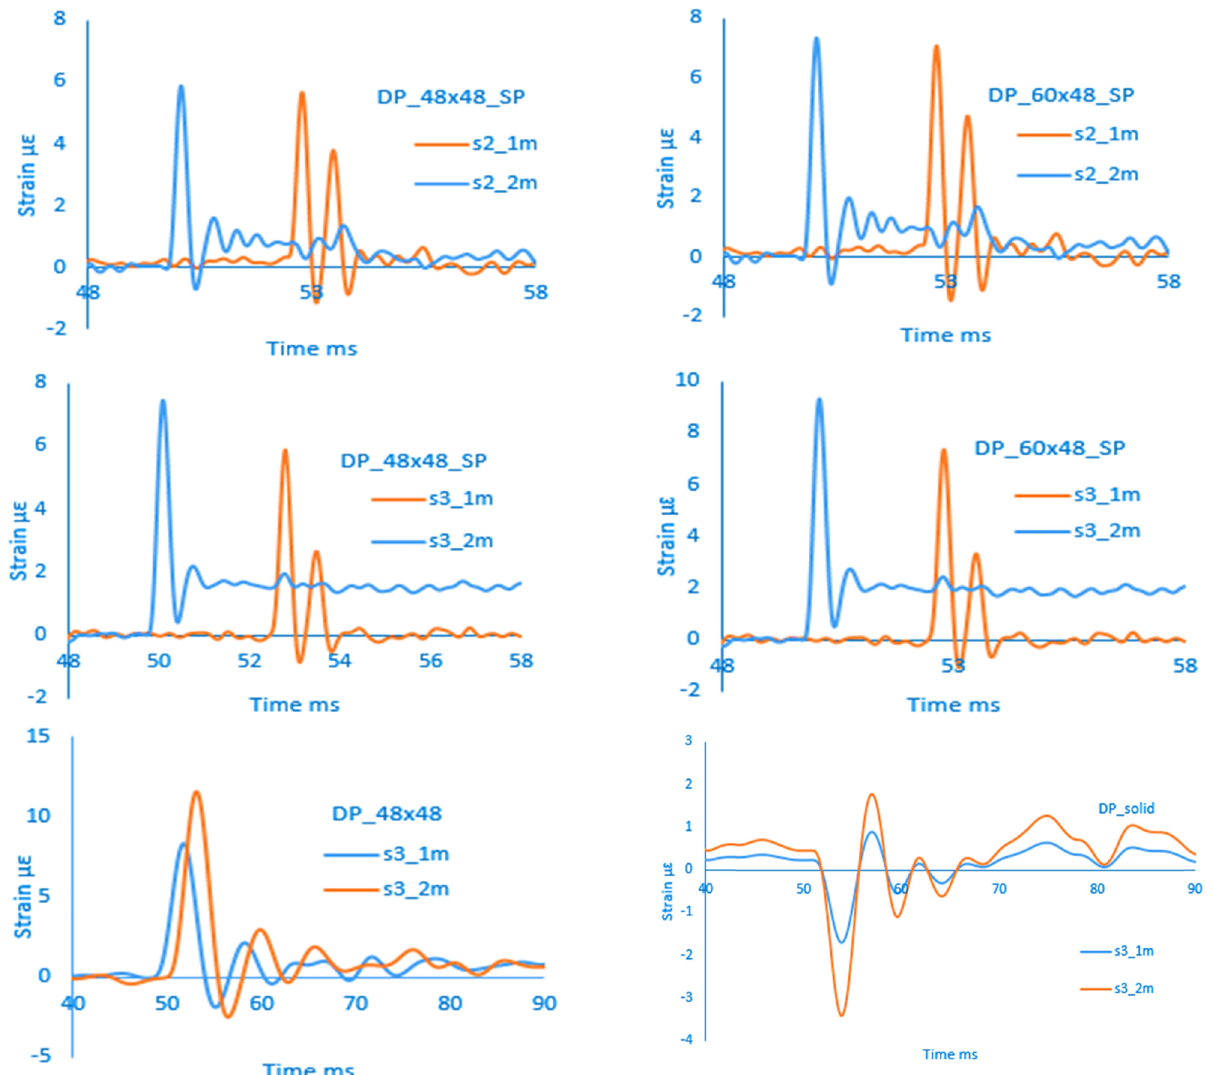
Figure 7: Reinforcement steel strain – time history at di ff erent drop